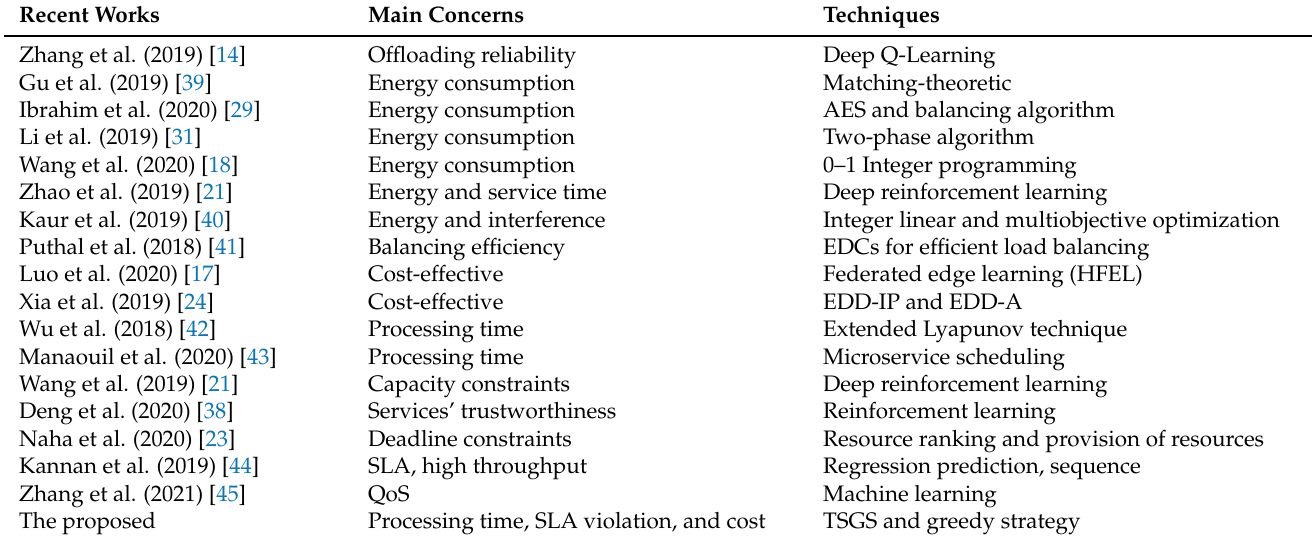
Table 1. Comparison of existing dynamically